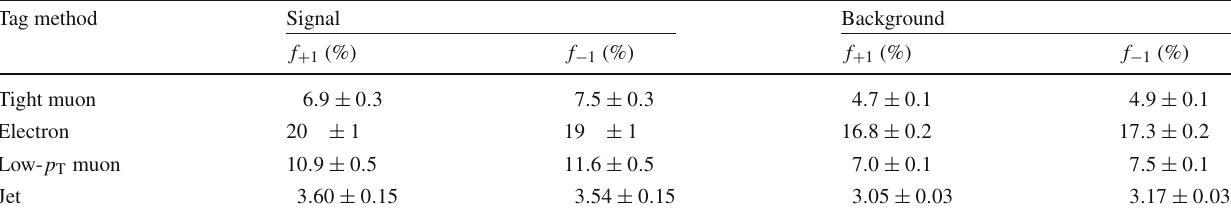
Table 2 Fractions f + 1 and f − 1 of events with cone charges of + 1 and − 1, respectively, for signal and background events and for the different tagging methods. Only statistical uncertainties are given